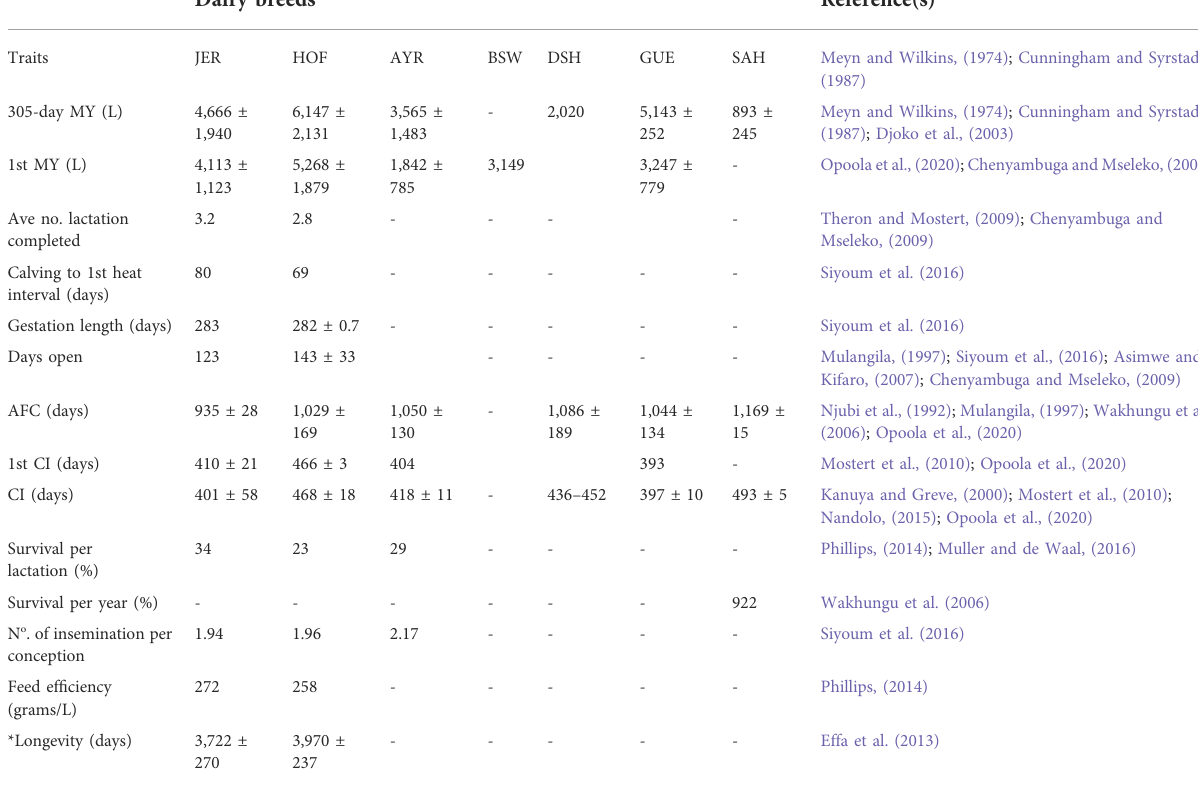
TABLE 2 Cited and documented average (±standard deviation) performances of Jersey breed amongst other dairy breeds in